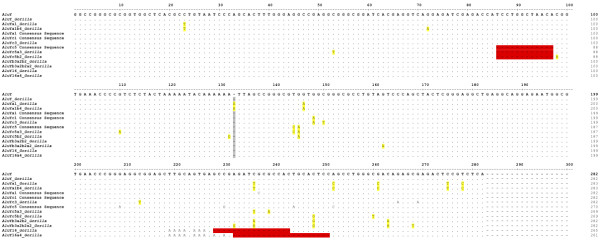
Alu sequence alignment. The consensus sequence for the AluY subfamily is shown at the top, with western lowland gorilla-specific Alu subfamilies listed below. The dots below the consensus denote the same base with insertions and deletions noted by dashes and mutations with the appropriate bases. The consensus sequences for the AluYa1, AluYc1, and AluYc5 subfamilies included for comparative purposes. Subfamily-specific diagnostic mutations are highlighted in yellow. Lineage-specific deletions are highlighted in red. AluY_Gorilla is 100% identical to the AluY consensus sequence. The shared 12-bp deletion identifying the AluYc5-derived Gorilla subfamilies is located at position 86. The 16-bp and 20-bp deletions identifying the AluY16_Gorilla and AluY16a4_Gorilla subfamilies are visible at positions 228 and 232.